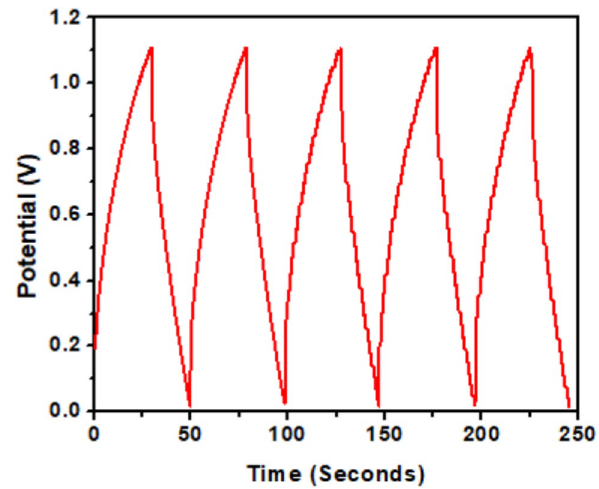
Fig. 6 CV analysis curve of EDLC devices based on UA carbon, G1 and G2 derived porous carbon